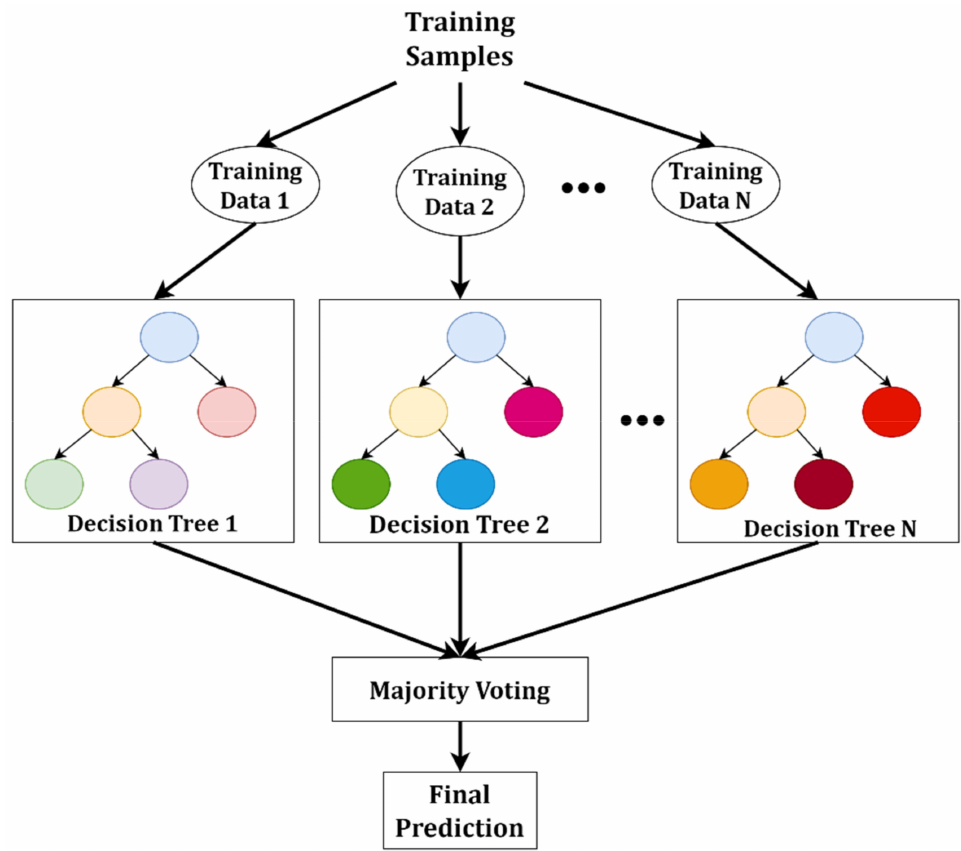
Figure 9. The architecture of Random